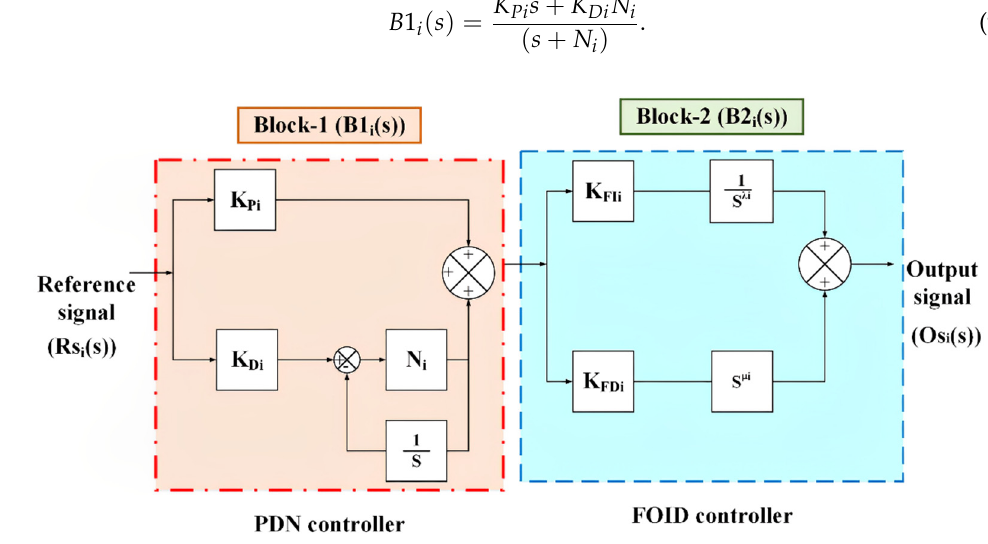
Figure 3. Layout of the proposed controller (PDN(FOID)).